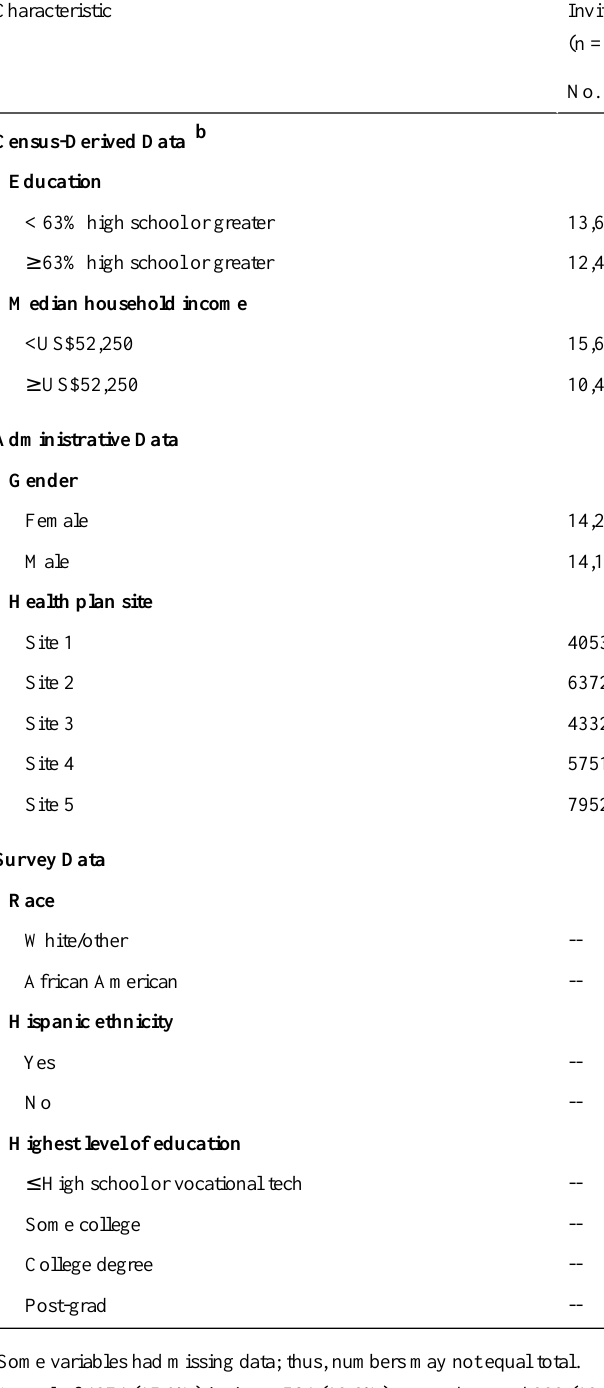
Table 2. Descriptive characteristics of invitees, responders, and enrollees in MENU